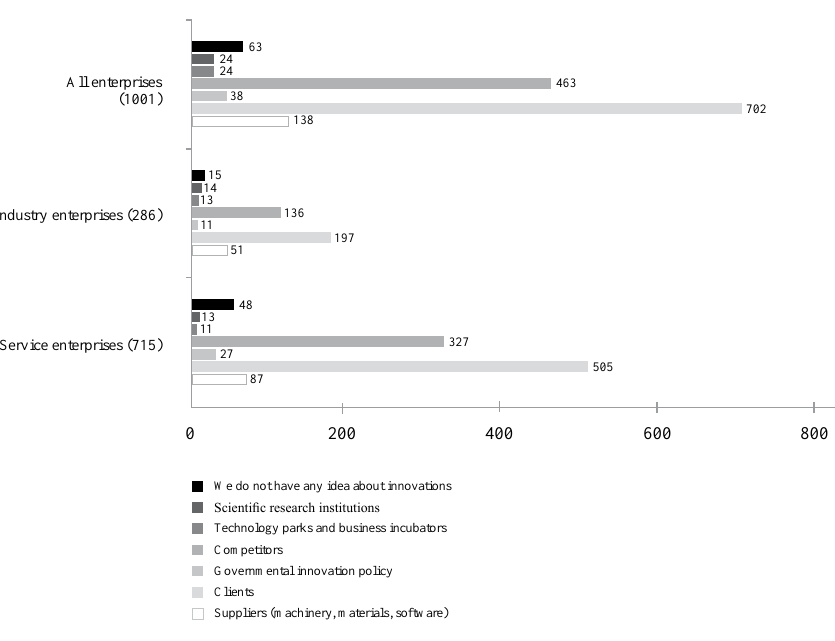
fig. 8. Factors fostering implementation of